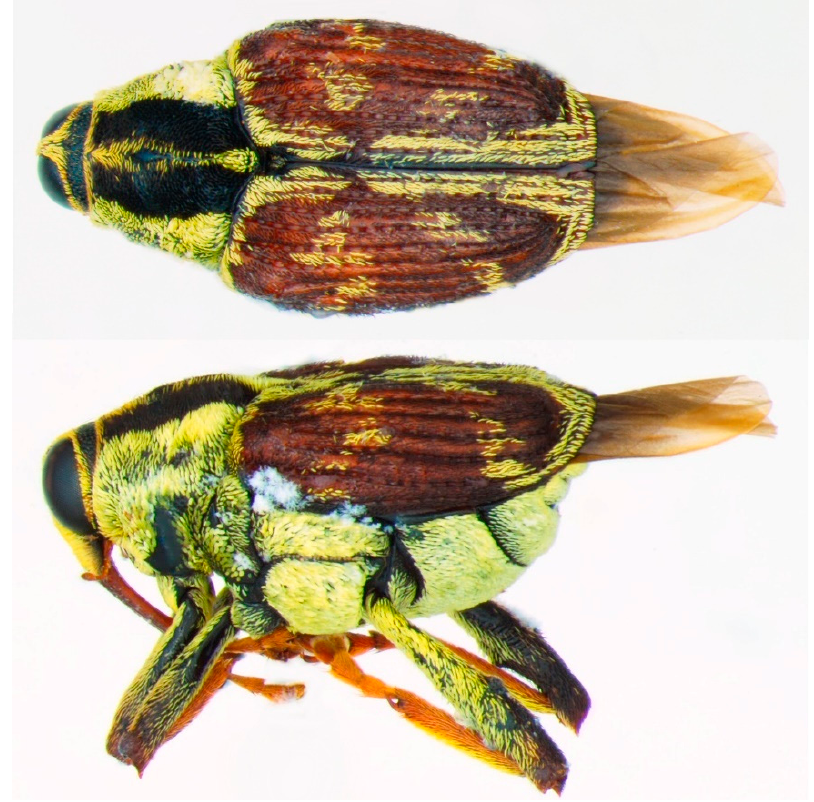
Figure 6. Philenis laselvaensis , dorsal and lateral habitus.